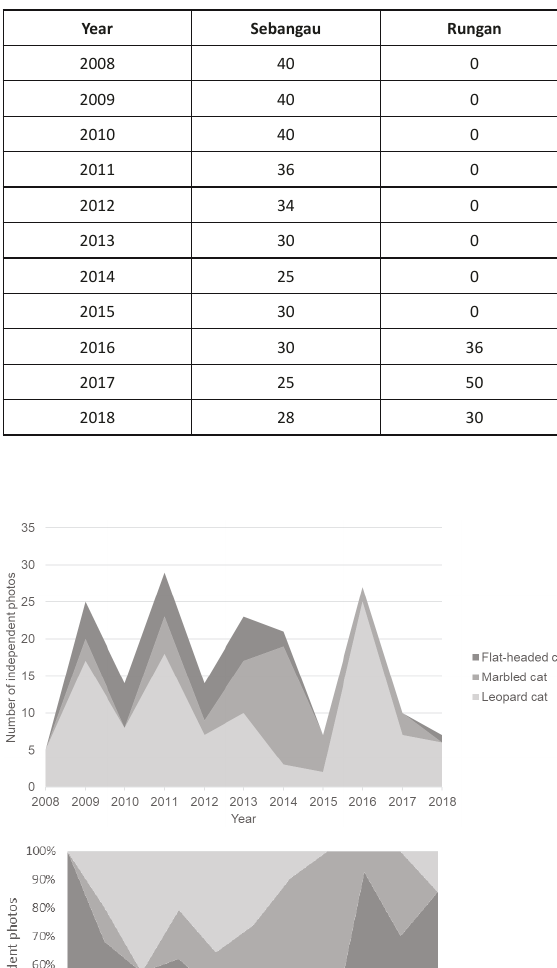
Table 1. Number of camera trap stations per year in the study